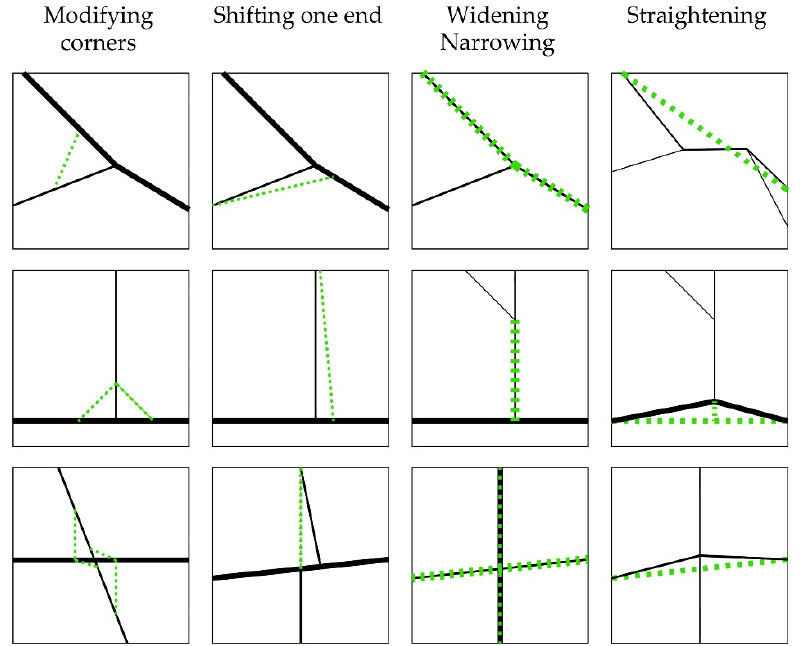
Figure 3. Instances of the alteration types.